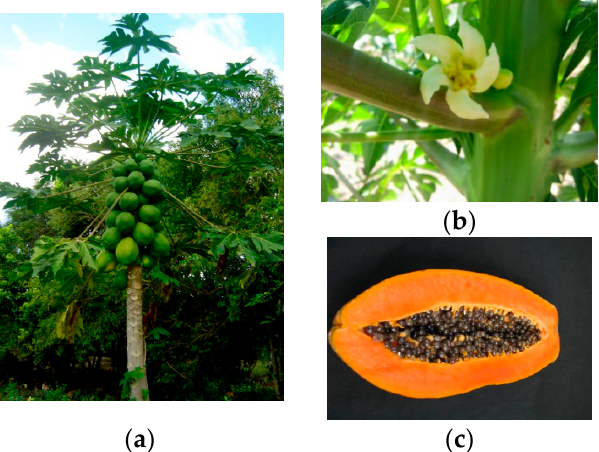
Figure 1. Images of Carica papaya L. (papaya CV Formosa): ( a ) Tree with leaves and green fruits, ( b ) female flower, and ( c ) ripe fruit with seeds and pulp. Photos: L. F. Santana.